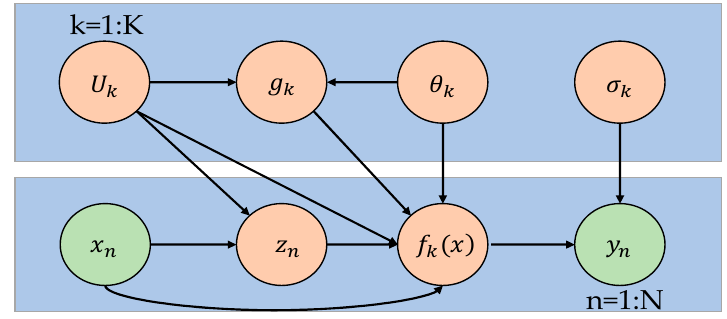
Figure 4. Wind speed prediction flow chart based on LSTM model.